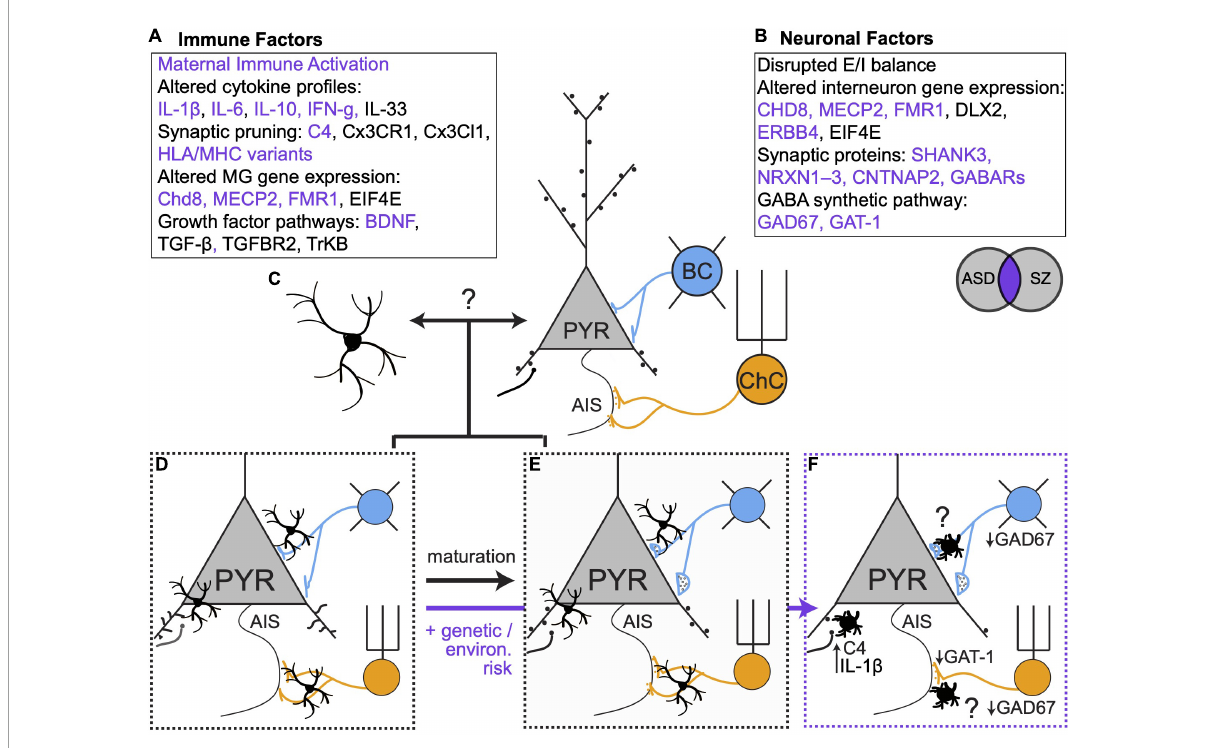
FIGURE2 Genetic, environmental and microglial influences on synaptic connectivity in development and disease. (A,B) Immune and neuronal factors (Gauthier et al., 2010; Marín, 2012; Nieto et al., 2013; Volk and Lewis, 2013b; El-Ansary and Al-Ayadhi, 2014; McAllister, 2014; English et al., 2015; Estes and McAllister, 2015; Sinclair et al., 2016; Ishizuka et al., 2017; Gao et al., 2018; Jiang et al., 2018; Huang et al., 2019; Trossbach et al., 2019; Wiebe et al., 2019; Barbosa et al., 2020; Chen et al., 2020; Boukouaci et al., 2021) known to be altered in ASD and SZ. Purple text represents elements that are affected in both disorders. (C) Open question: to what extent do bidirectional microglia-neuron interactions regulate synaptic connectivity? (D,E) . Microglia regulate excitatory and inhibitory connectivity during healthy development. (F) In the context of genetic and environmental risk factors, microglia alter their phenotypes and contribute to altered synaptic connectivity. Many open questions remain, especially regarding the role of microglia in mediating maladaptive changes in inhibitory synaptic